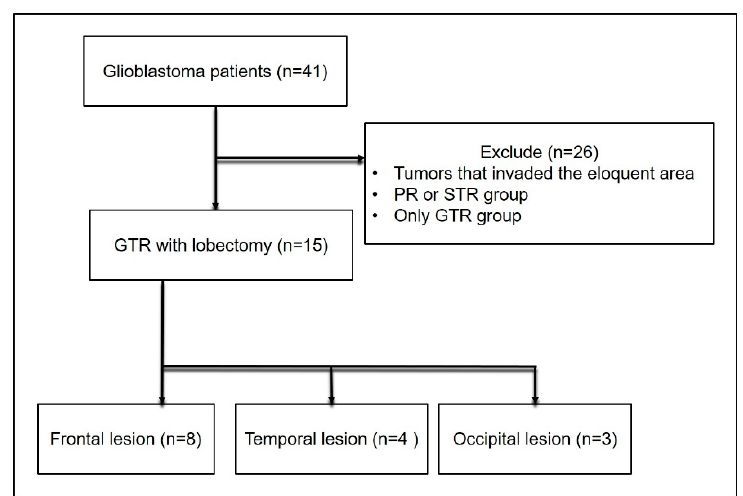
Figure 1. CONSORT flow diagram of disposition of patients enrolled in the study.